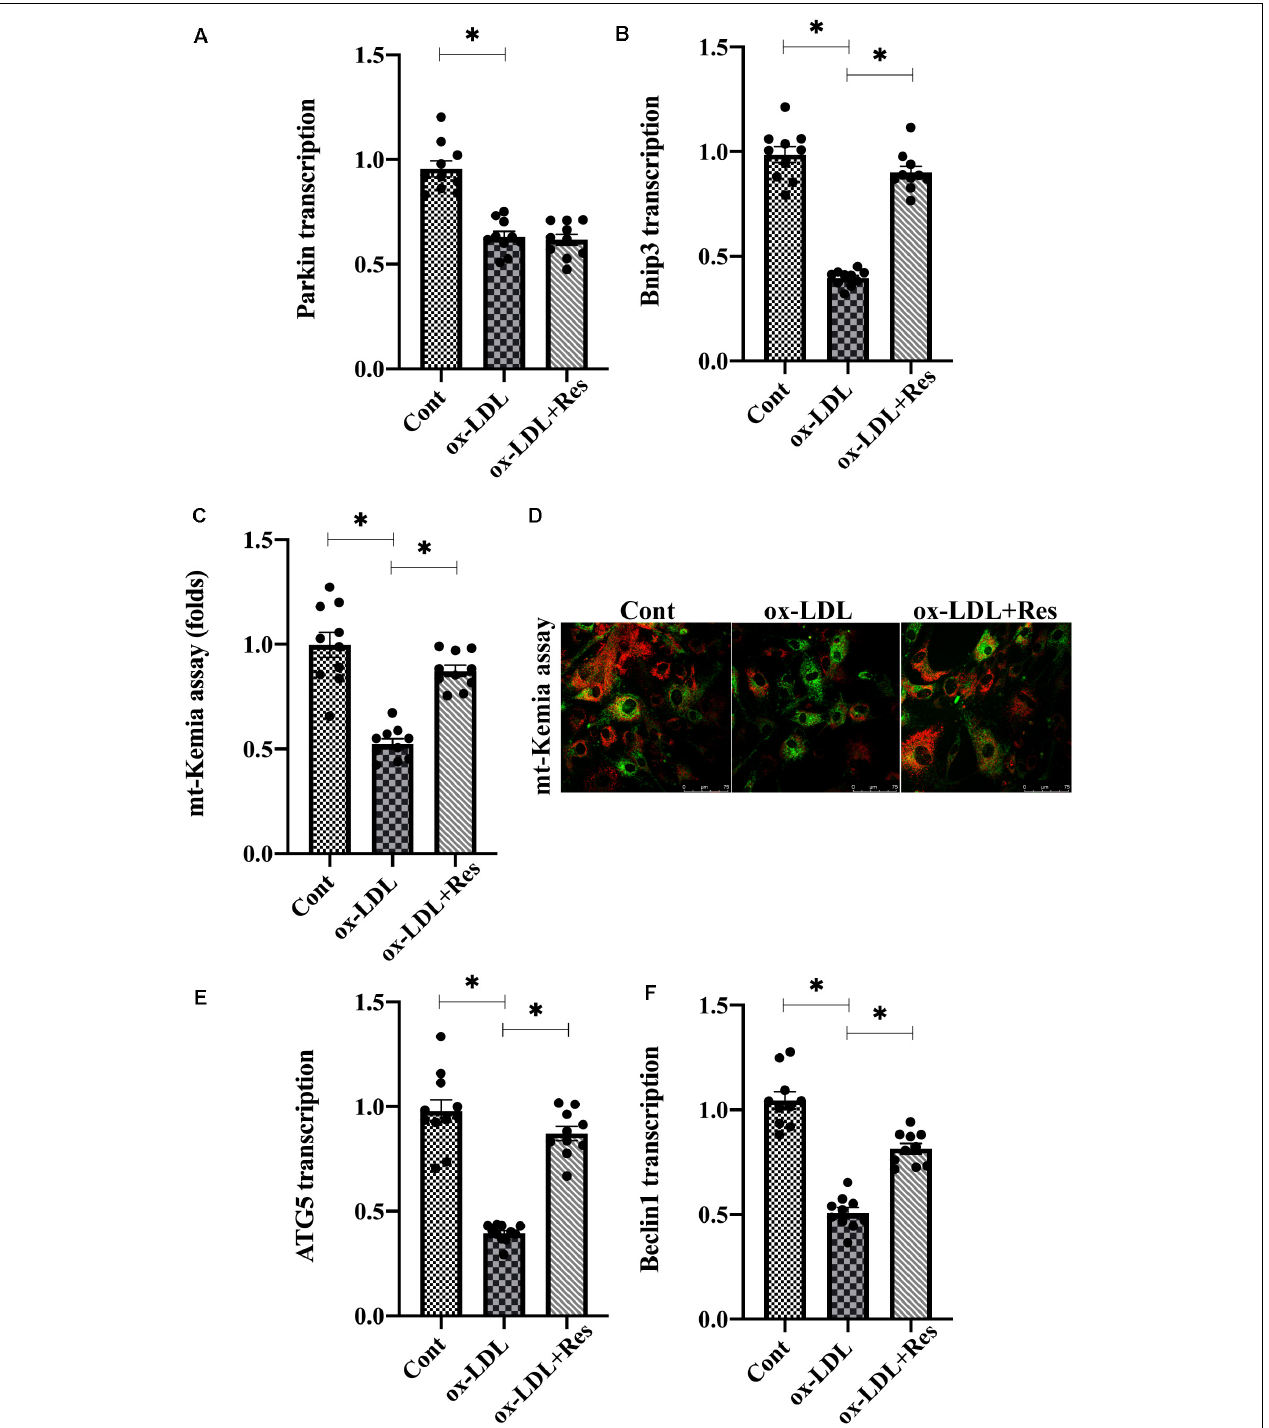
FIGURE 3 | Resveratrol activates Bnip3-related mitophagy in endothelial cells in the presence of ox-LDL. (A,B) After treatment with ox-LDL, RNA in endothelial cells was collected and Parkin and Bnip3 transcription was measured. (C,D) Endothelial mitophagy was detected through mt-Kemia. The acid mitochondria number was recorded to reflect the activity of mitophagy. (E,F) ATG5 and Beclin1 transcription was determined through qPCR. Endothelial cells were treated with ox-LDL in the presence or absence of resveratrol. * p < 0.05.